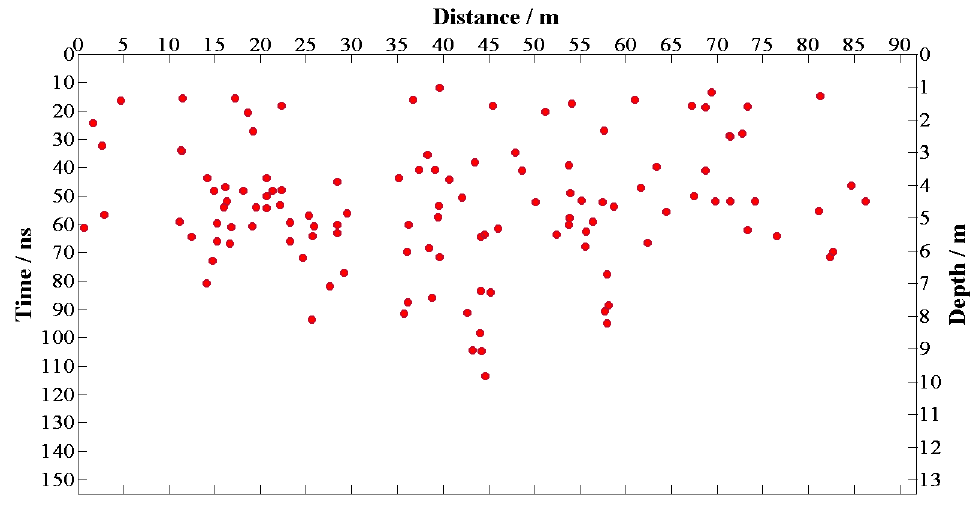
Figure 12. The result of rock positioning for LPR data. The relative dielectric constant is set to 3.